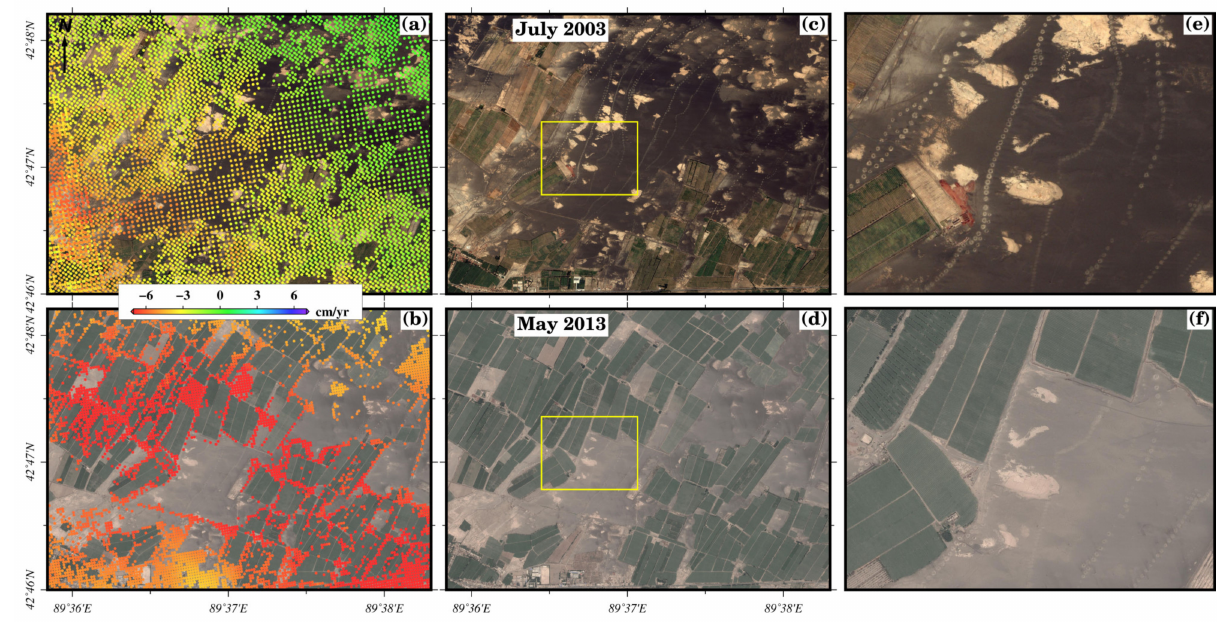
Figure 9. Deformation rate in the blue rectangular area of Figure 8 from ( a ) ALOS-1/PALSAR, ( b ) ascending track Sentinel-1 data. ( c , d ) Optical images of this area in July 2003 and May 2013, respectively. ( e , f ) Zoom-ins of the yellow rectangular area in ( c , d ). Background image: Google Maps satellite